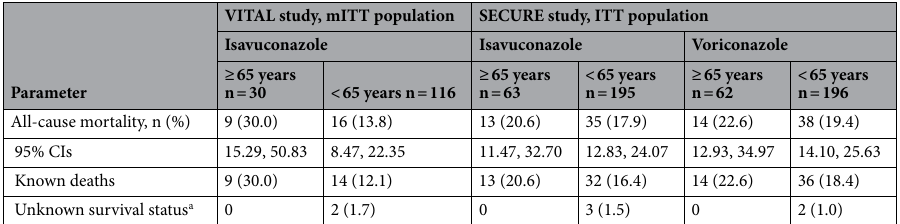
Table 5. Analysis of all-cause mortality through Day 42. Crude mortality rates are calculated within treatment group. The 95% CI for treatment group is based on a binomial distribution. CI confidence interval, ITT intent to treat, mITT modified ITT, n number of patients. a Patients with the last known survival status before day 42 assessment/missing; treated as death(s) while calculating all-cause mortality.